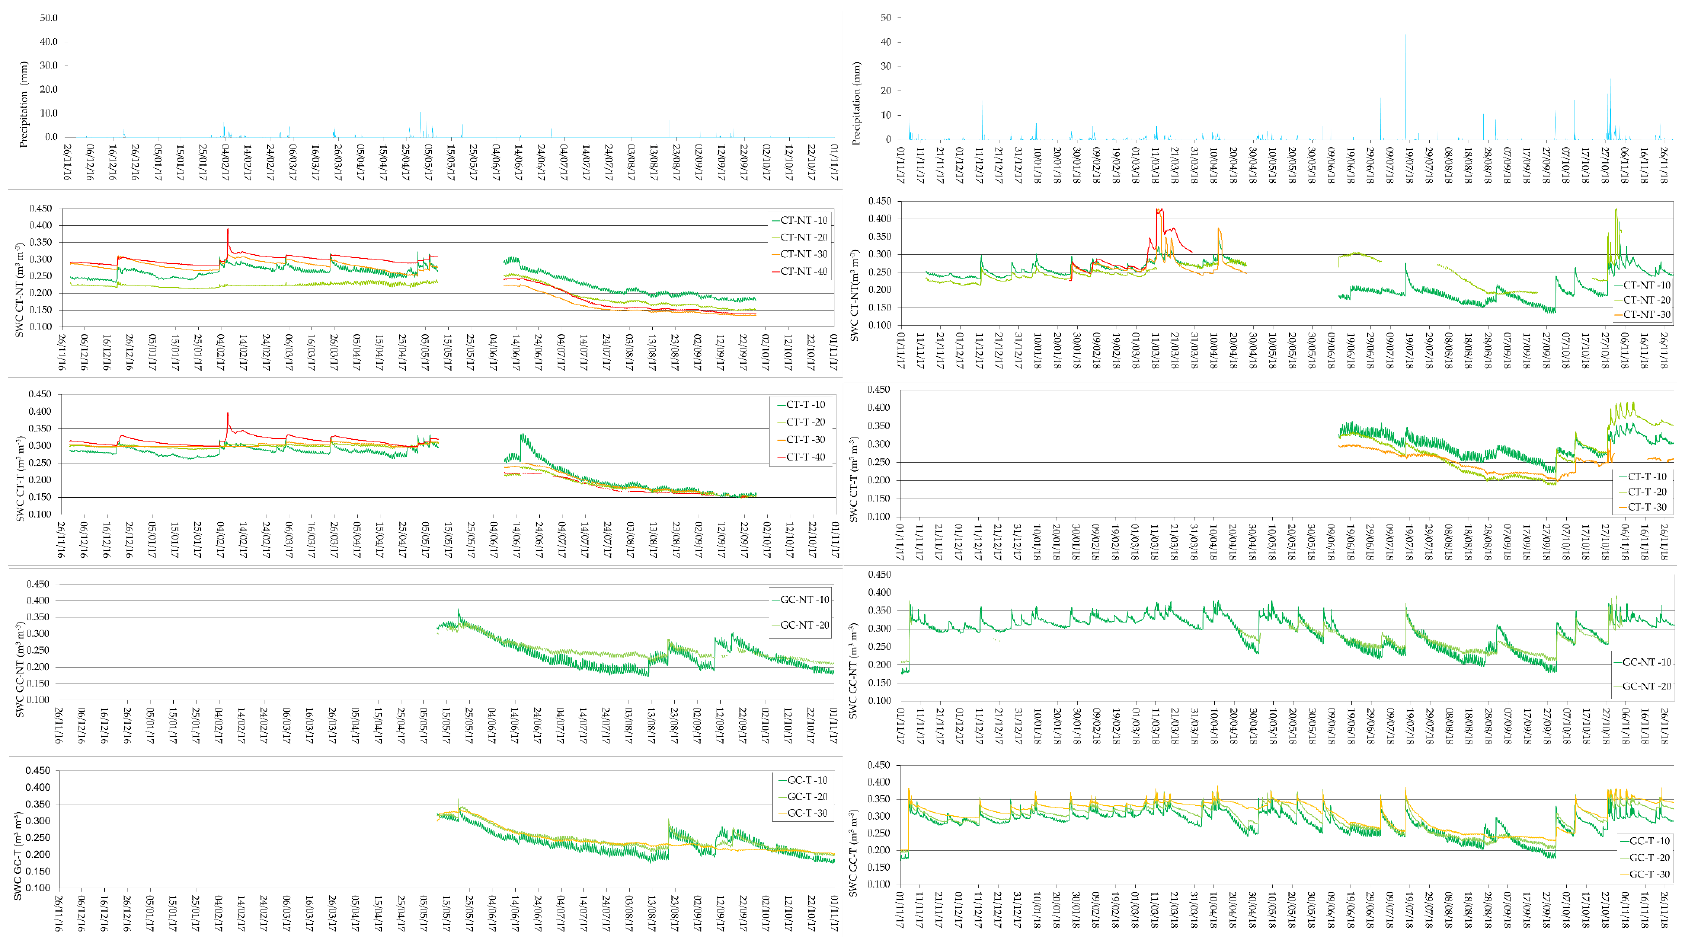
Figure 2. Precipitation ( top ), CT ( middle ) and GC ( bottom ) volumetric soil water content in Year 1 (left side) and Year 2 (right side).